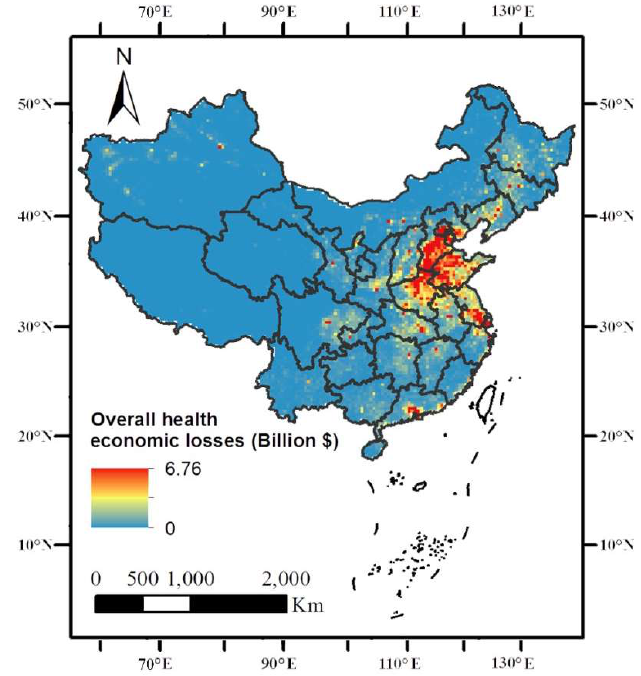
Figure 4. Spatial distribution of 10-year annual average health economic losses from exposure to six ambient pollutants in China.